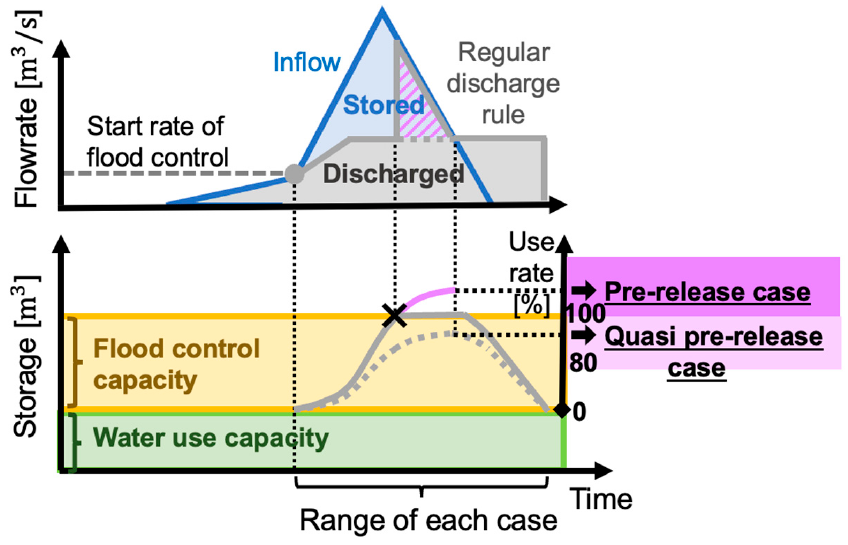
Figure 5. Schematic diagram for “pre-release case” and “quasi-pre-release case”. The period of each case is defined as from the beginning of flood control until the storage level returns to its initial state. At the beginning, only the flood control capacity is set as empty. The operation for reducing storage after floods is assumed as being achieved by the maximum discharge during flood